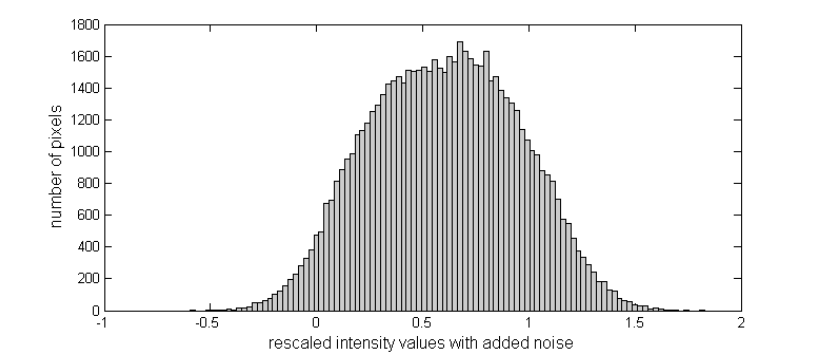
Figure A1. The histogram of the four-valued image after Gaussian noise had been